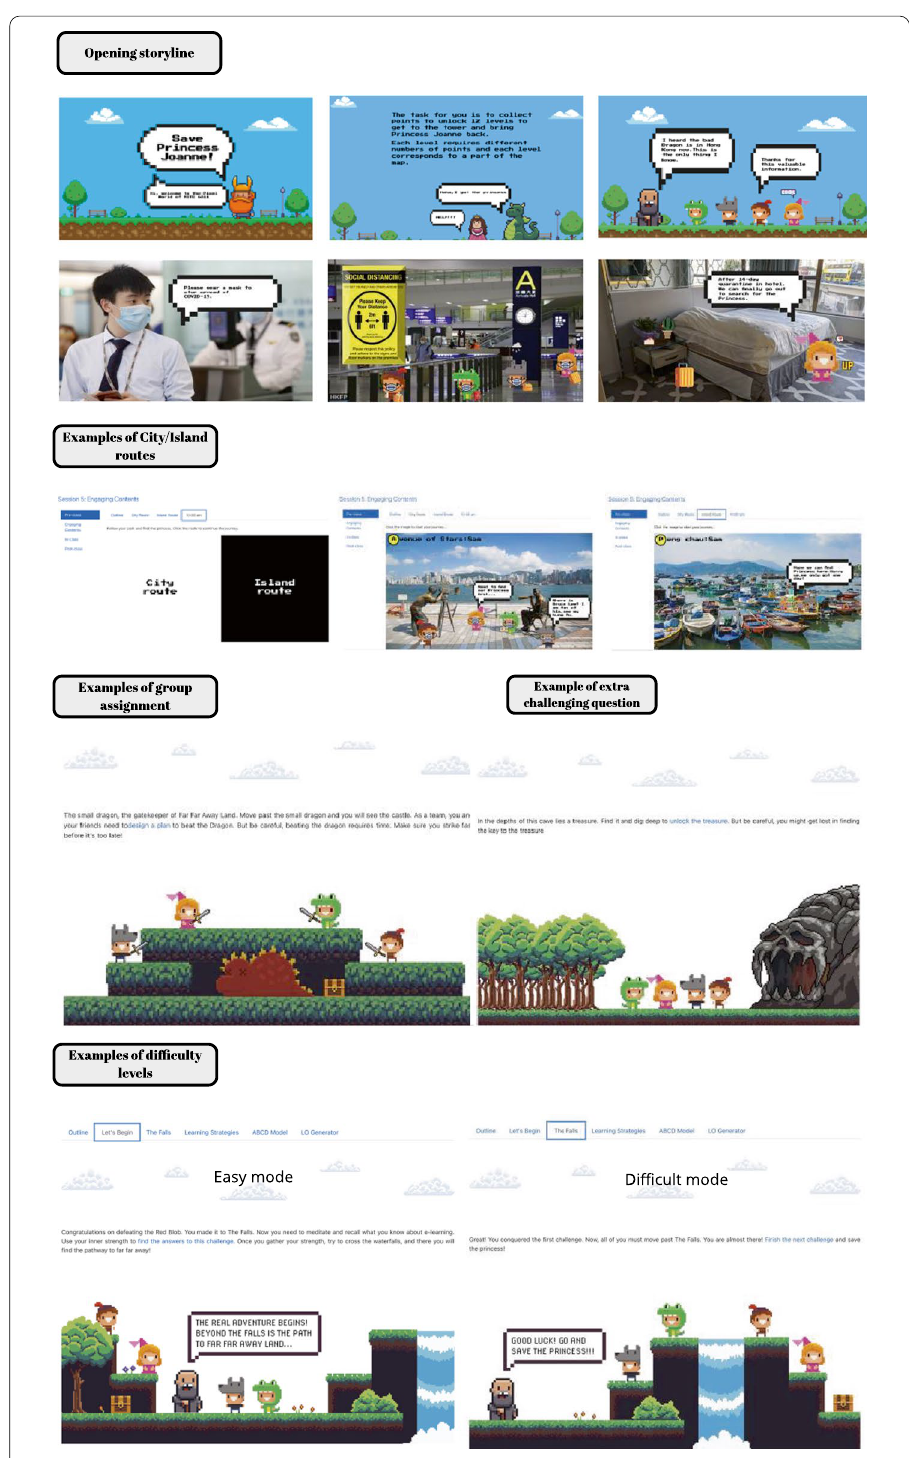
Fig. 5 Fantasy and embedded narrative in individual quizzes, group assignments, and challenging